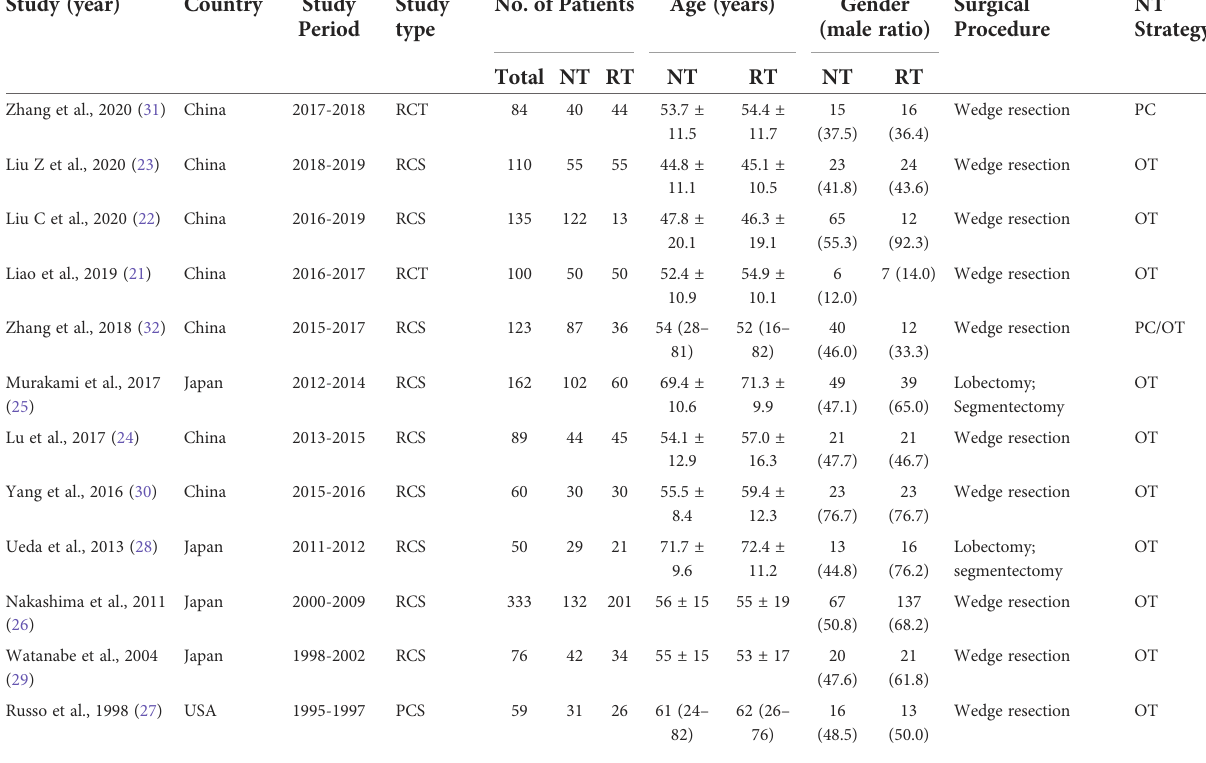
TABLE 1 Baseline characteristics of the included studies.